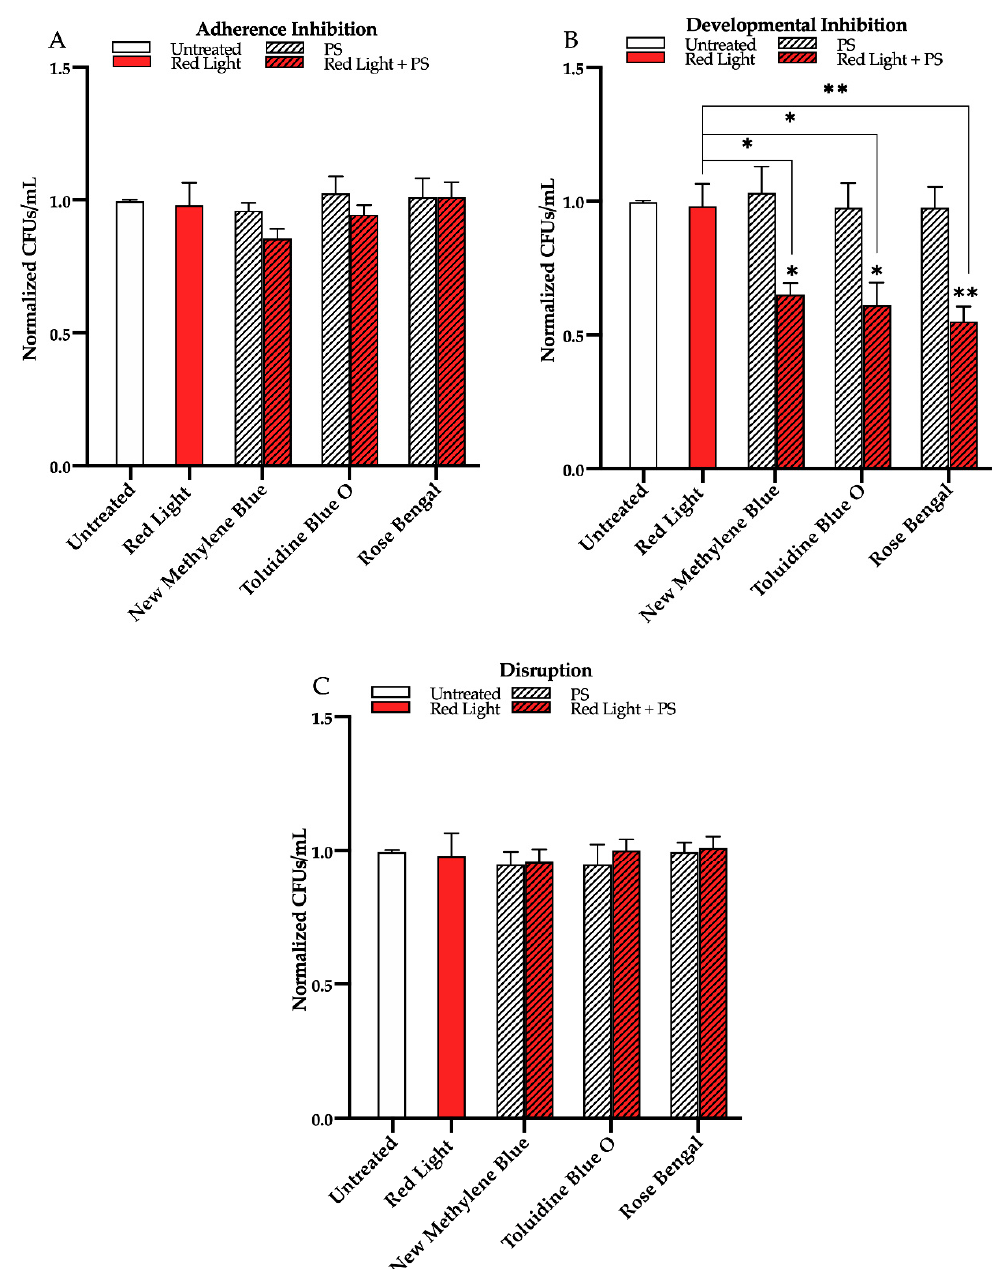
Figure 3. Effects of red visible light in combination with the photosensitizing compounds new methylene blue, toluidine blue O, and rose bengal on C. albicans biofilms. Effects of red light in combination with the photosensitizing compounds in the ( A ) adherence inhibition, ( B ) developmental inhibition, and ( C ) disruption biofilm assays. Untreated control (Untreated), red light alone (Red Light), photosensitizing compound alone (PS), and red light in combination with the photosensitizing compound (Red Light + PS) are shown. Colony forming units per 1mL (CFUs/mL) were measured to determine viable cell counts from the biofilms at the end of each biofilm assay. Standard deviations are shown for each sample ( n = 3). The average CFUs/mL of the untreated control samples for each assay were normalized to 1. Significance comparisons are relative to the untreated control unless otherwise noted with significance bars and were determined using Student’s unpaired two-tailed t-tests assuming unequal variance for p ≤ 0.05 (*), and p ≤ 0.01 (**).